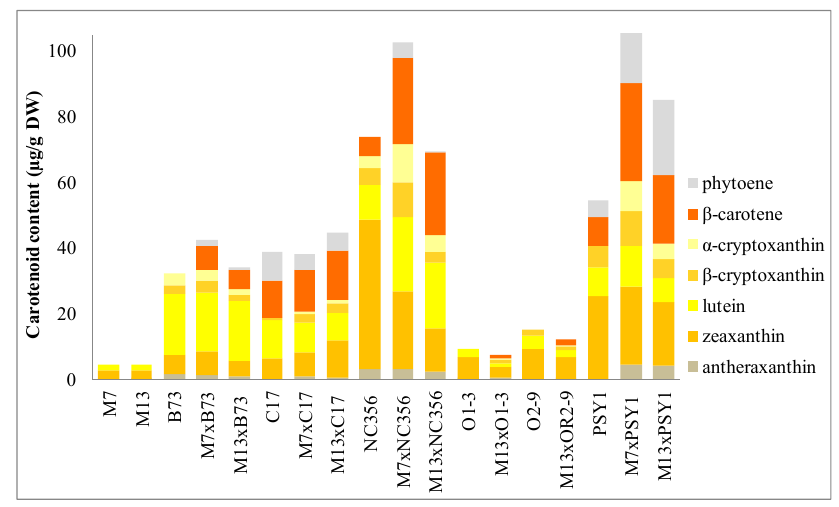
Figure 3. Carotenoid profiles in the endosperm (30 DAP) of parental lines M7, M13, B73, C17, NC356, O1-3, O2-9, PSY1, and the corresponding hybrids.